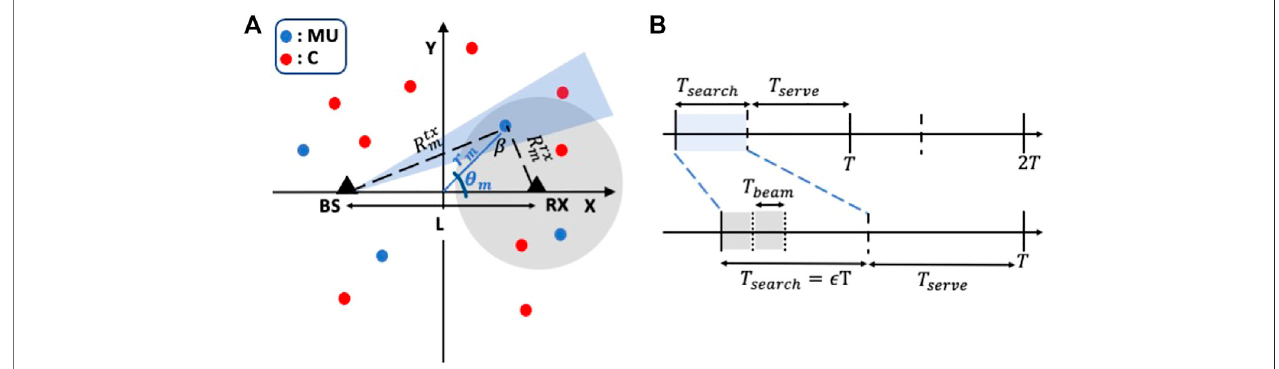
0 ) andindicatedbyatriangle isadualfunctionaltransmitter 2 , 0 ) 2 ,